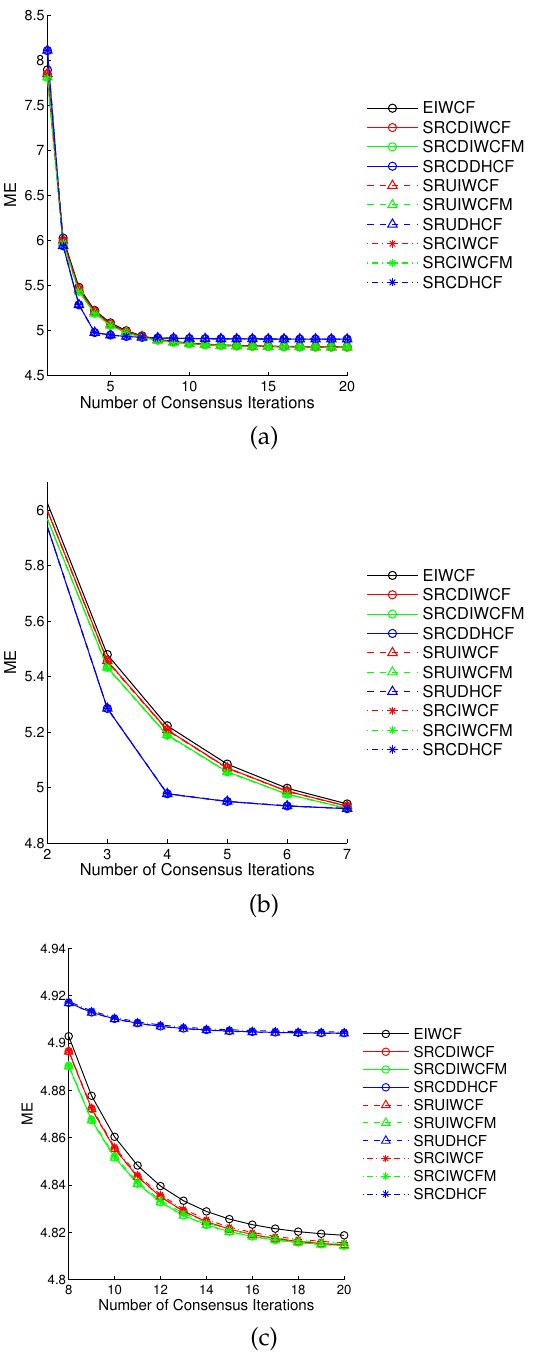
Figure 1. The comparison of mean errors (ME) of proposed square-root sigma-point information consensus filters and the state-of-the-art extended information weighted consensus filter (EIWCF) for 50 Monte Carlo simulations. The details of the ( a ) is shown in ( b ) for iterations 2–7 and ( c ) for iterations